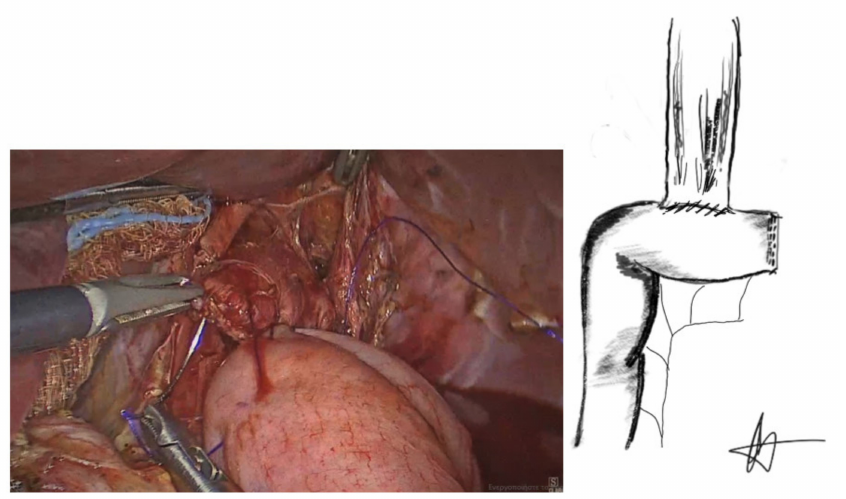
Figure 4. Posterior outer seromascular